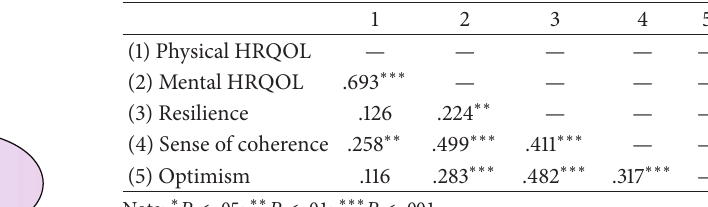
Table 1: Correlations among personal strengths and